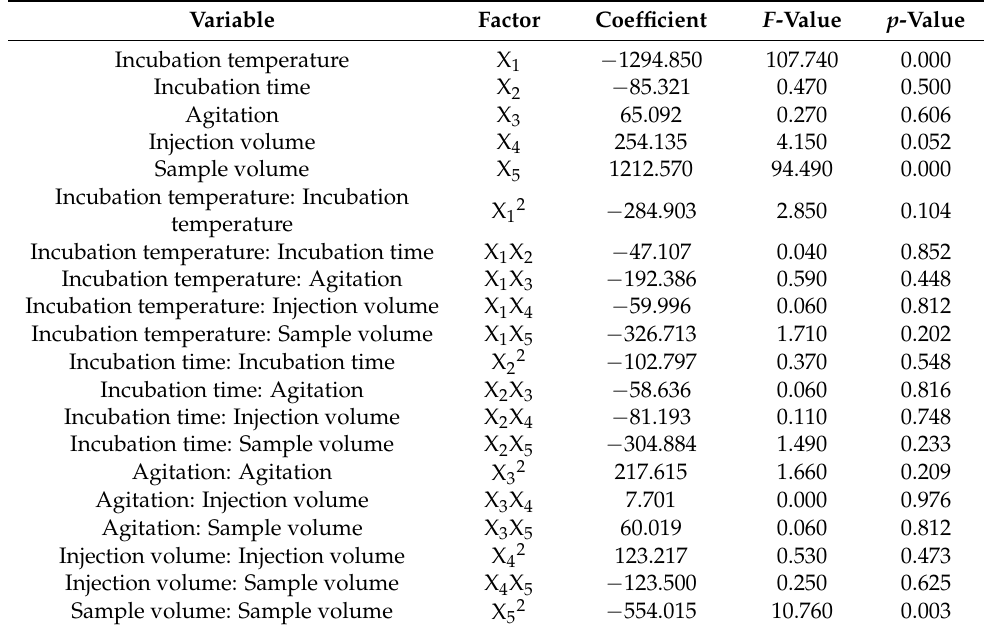
Table 4. ANOVA of the quadratic model for the discrimination of the different petroleum-derived products (PDPs) in the water samples.